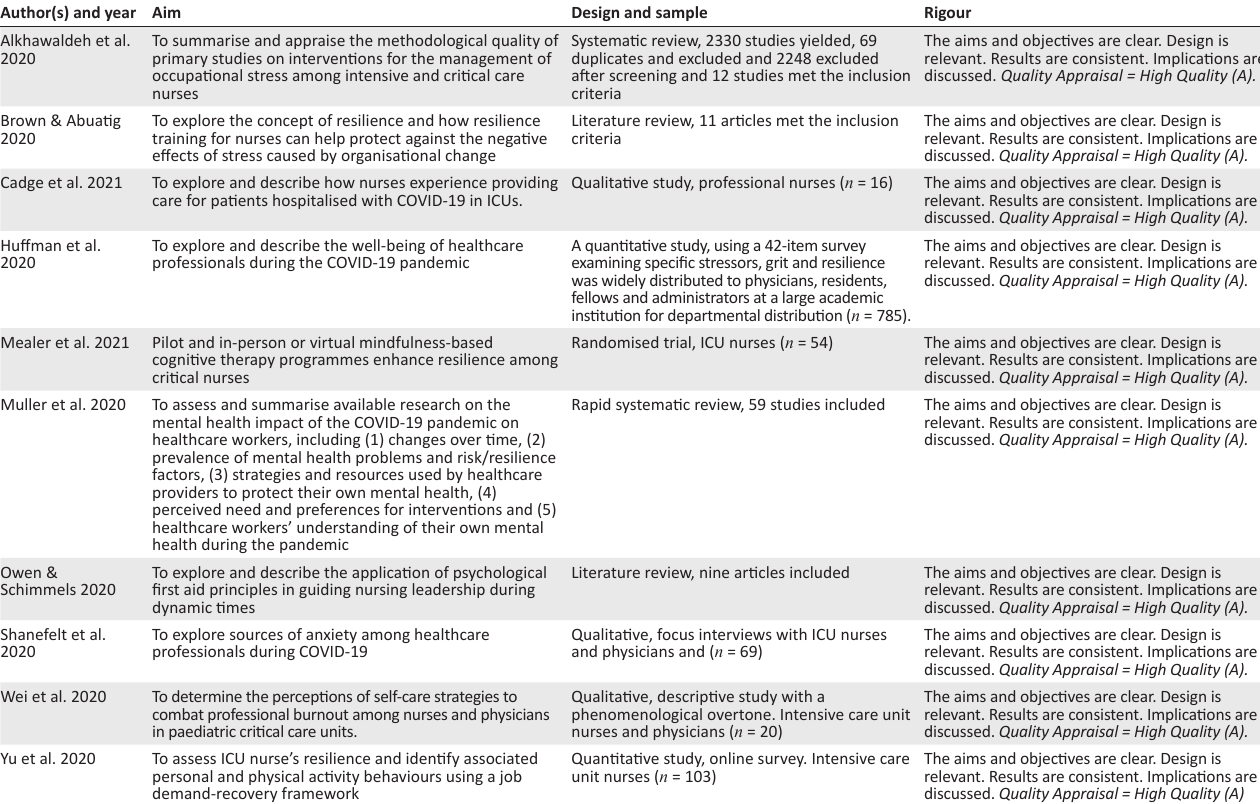
TABLE 1: A detailed description of the included studies †